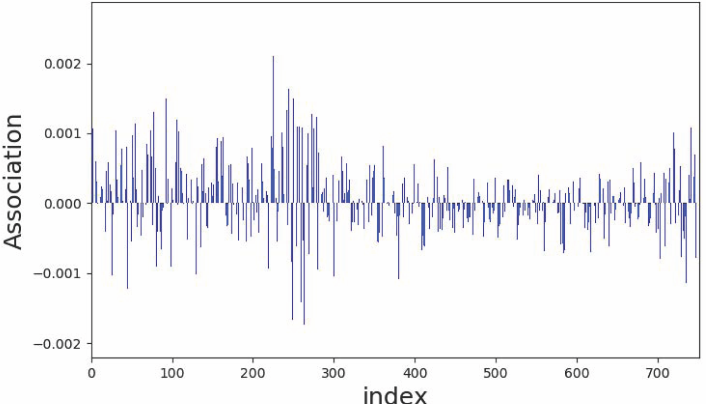
Figure 8. One example of the ten learning parameter β s.